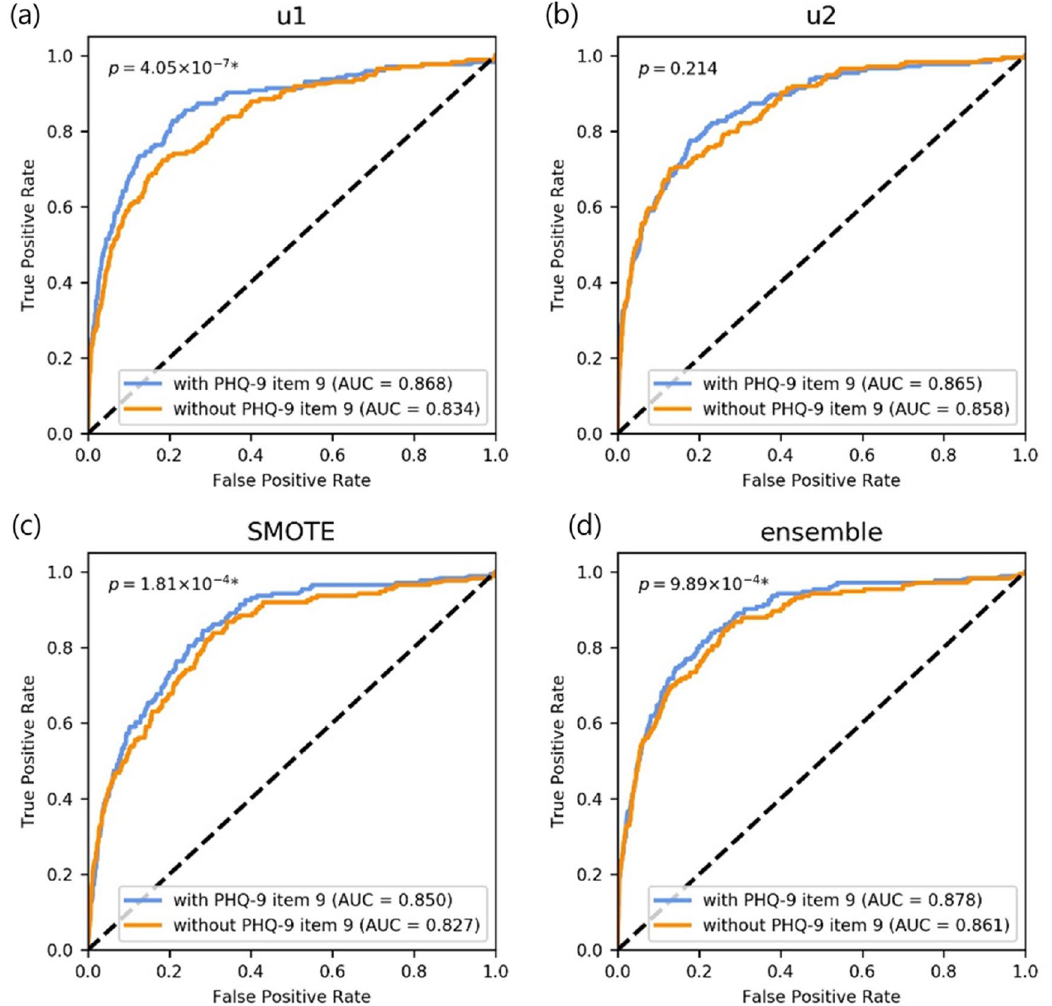
Figure 3. Receiver operating characteristic (ROC) curves of models using ( a ) u1, ( b ) u2, ( c ) SMOTE, and ( d ) ensemble of u1, u2, and SMOTE for ablation study. There were significant but small differences between the diagnostic performance of the model with and without Item 9 of PHQ-9 except for u2. Each p -value was calculated from DeLong’s test comparing two ROC